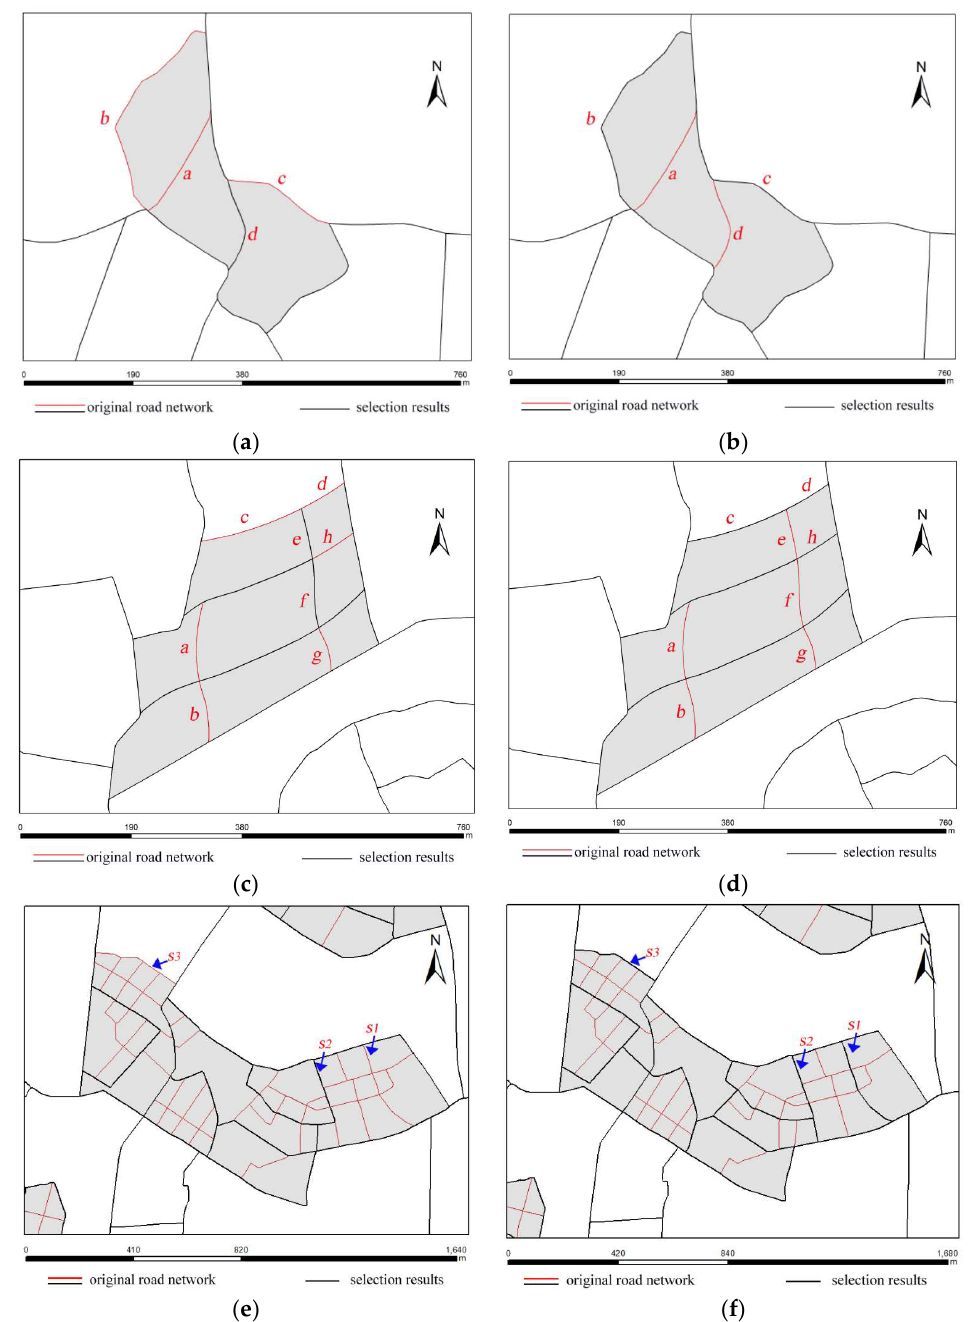
Figure 14. Comparison of three typical areas for aggregated areas with more than 2 small meshes: ( a ) selection result for the aggregated area with the minimum number of small meshes based on the mesh-based method; ( b ) selection result for the aggregated area with the minimum number of small meshes based on the proposed method; ( c ) selection result for the aggregated area with the median number of small meshes based on the mesh-based method; ( d ) selection result for the aggregated area with the median number of small meshes based on the proposed method; ( e ) selection result for the aggregated area with the maximum number of small meshes based on the mesh-based method; and ( f ) selection result for the aggregated area with the maximum number of small meshes based on the proposed method.